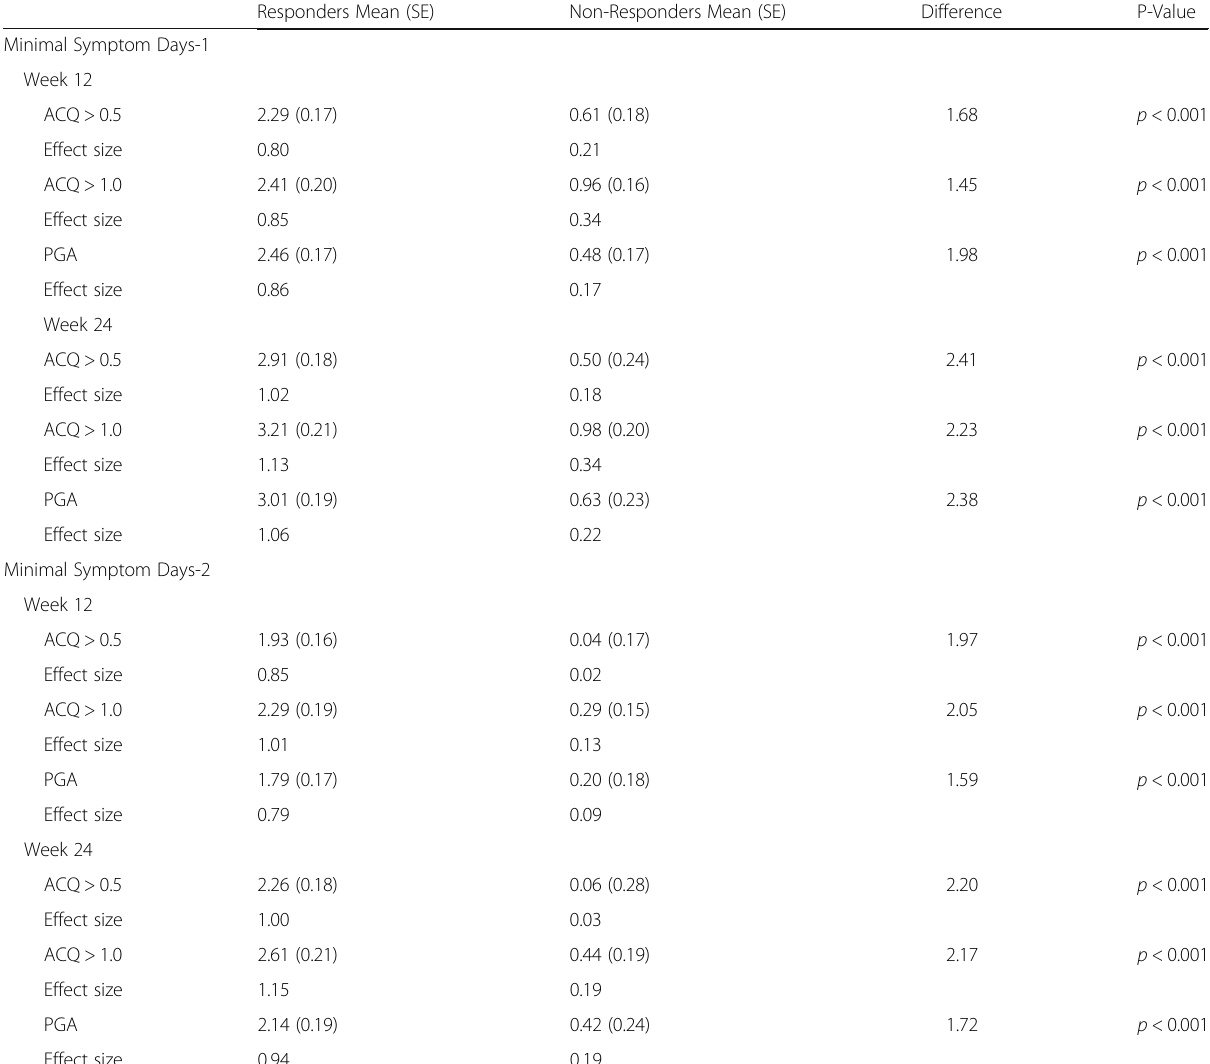
Table 3 Responsiveness of ASD Minimal Symptom Days in a 7-Day Period at Weeks 12 and 24